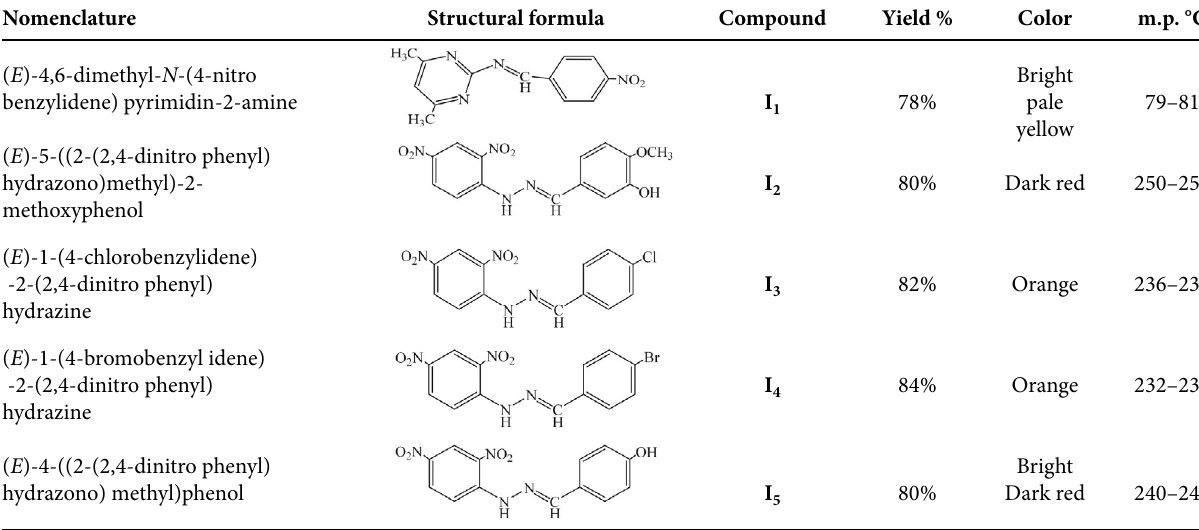
Table 1. Names, structural formulae, symbol, yields, colors and melting points of azomethine compounds I 1 –I 5